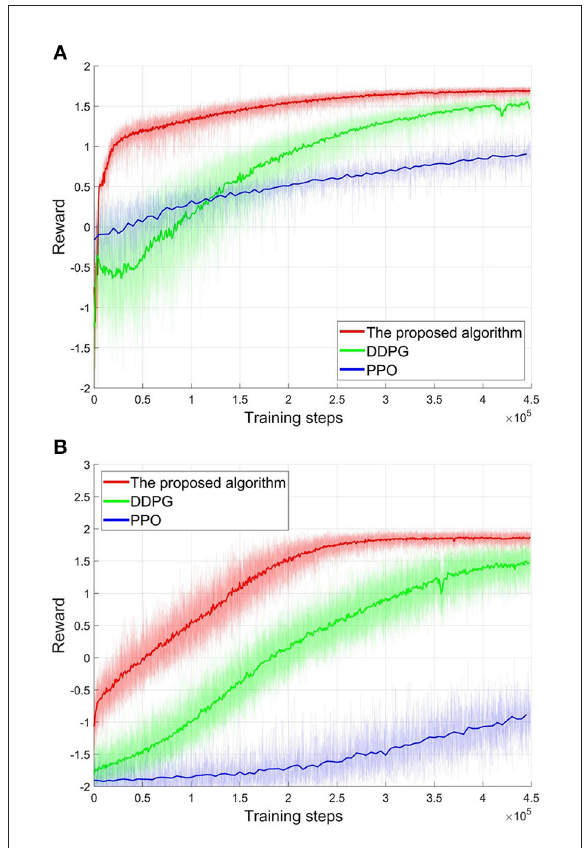
FIGURE8 The reward curves of different algorithms. (A) The first scenario. (B) The second scenario.